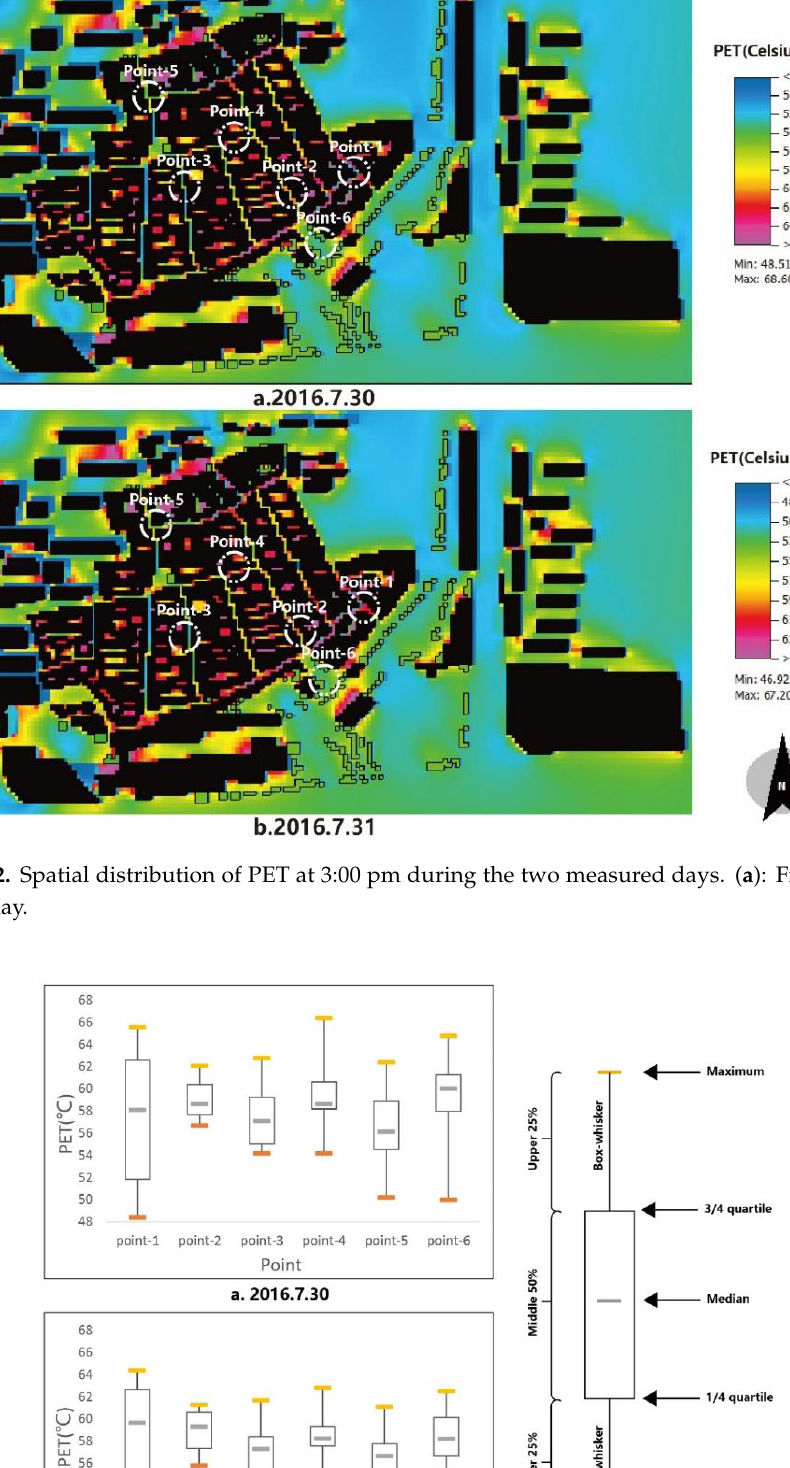
Figure 12. Spatial distribution of PET at 3:00 pm during the two measured days. (a): First day; (b): Second day.